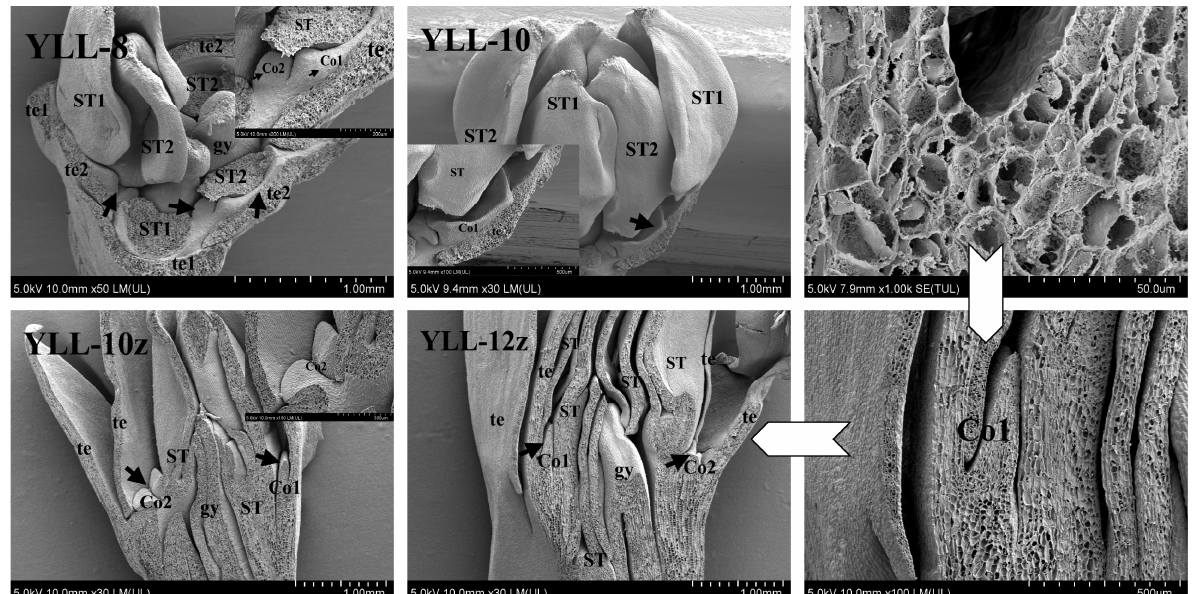
Figure 6. Scanning electron microscopic images of YLL fragmented corona during